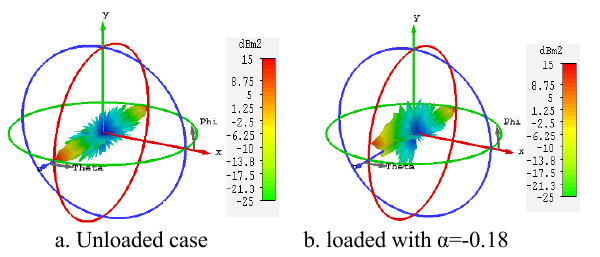
Fig. 5. The 3D RCS for unloaded and loaded metallic sheet at 11.75 GHz.